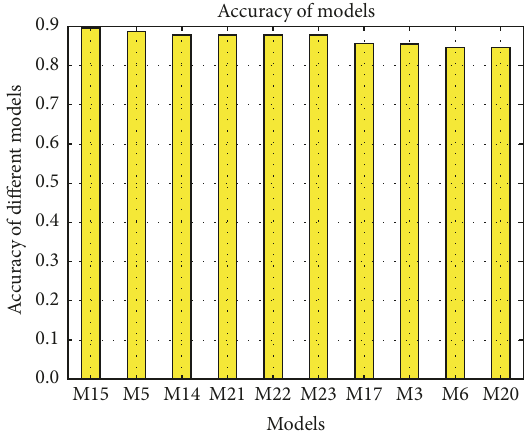
Figure 5: Average accuracy of top ten models on testing set. It is obvious that M15 is the best model with the highest accuracy 0.89 on testing